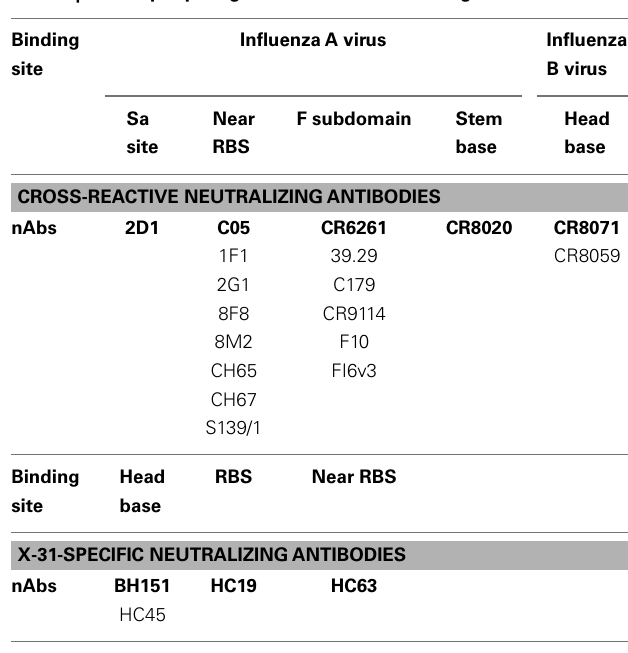
FIGURE 2 | B-cell epitope on the structure of neutralizing antibody F10 binding HA protein (PDB ID: 3FKU) . (A) Complex of F10-HA [A/Vietnam/1203/04(H5N1)].The structure is a HA trimer of three identical copies (one of them is colored as cyan and green; the other two are in gray). Each copy contains the HA1 (cyan) and HA2 (green) chain, also the heavy chain of F10 (red), the neutralized epitope is highlighted in pink; (B) Close-up view of neutralized epitope identified on the structure (highlighted as pink surface). Table 2 | B-cell epitope regions of the 22 neutralizing antibodies